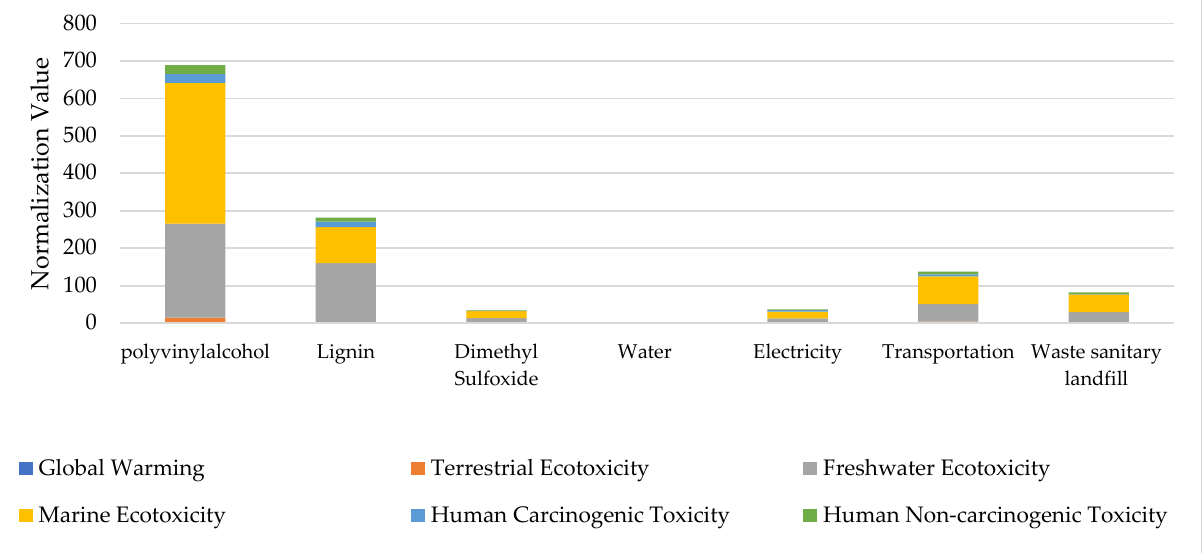
Figure 11. Midpoint impact categories of mulch film PVA with lignin (40PVA/60LN) based on the Recipe Midpoint (H) method.